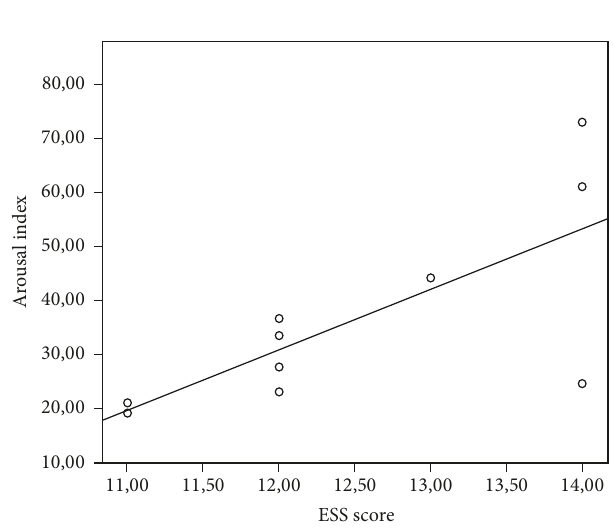
Figure 3: Relationship between ESS score and arousal